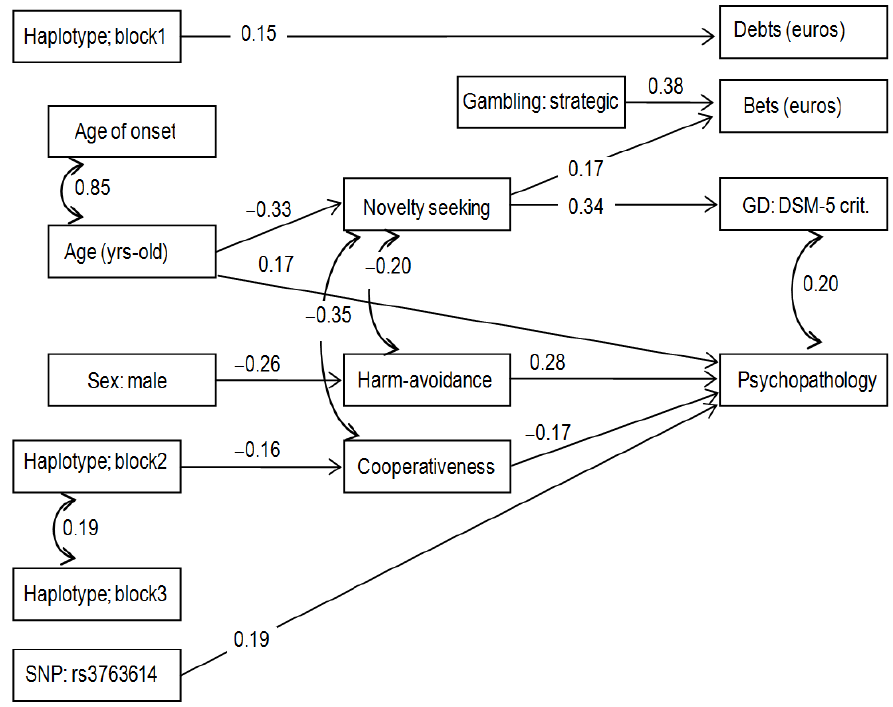
Figure 2. Path diagram: standardized coefficients ( n = 146). Note: Only significant parameter estimates were retained in the final model. SNP: single nucleotide polymorphism. GD: Gambling Disorder.